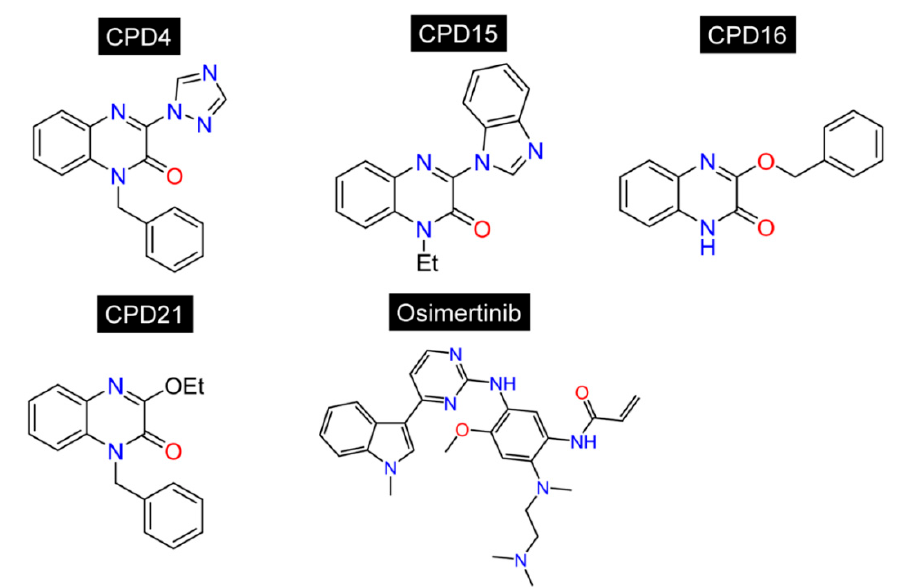
Figure 3. The chemical structures of selected compounds including CPD4, CPD15, CPD16, and CPD21 as well as a reference drug (osimertinib).